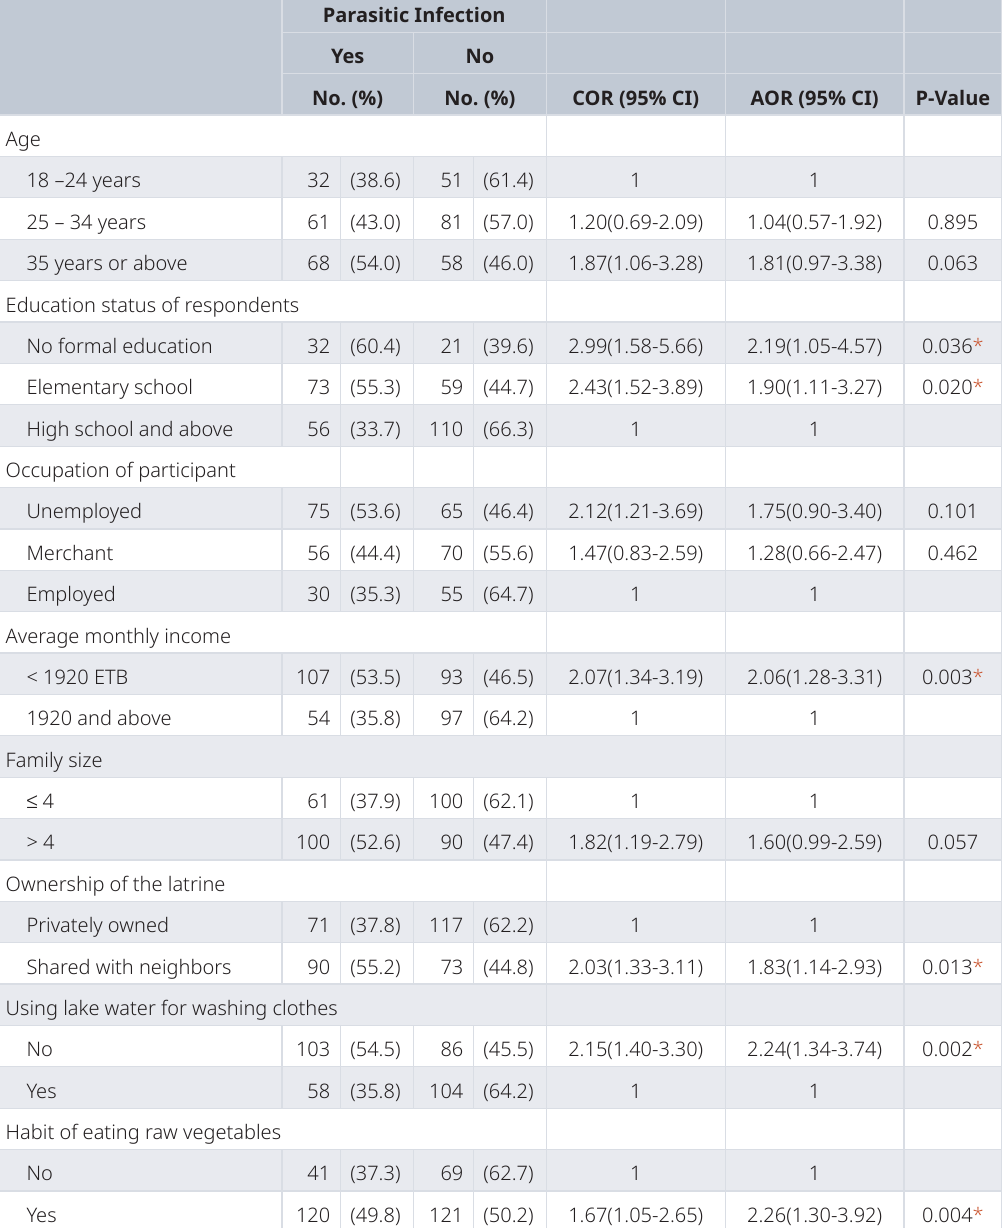
Table 2. Associated factors for parasitic infection among pregnant women at health centers in Hawassa, Southern Ethiopia, 2020. Parasitic